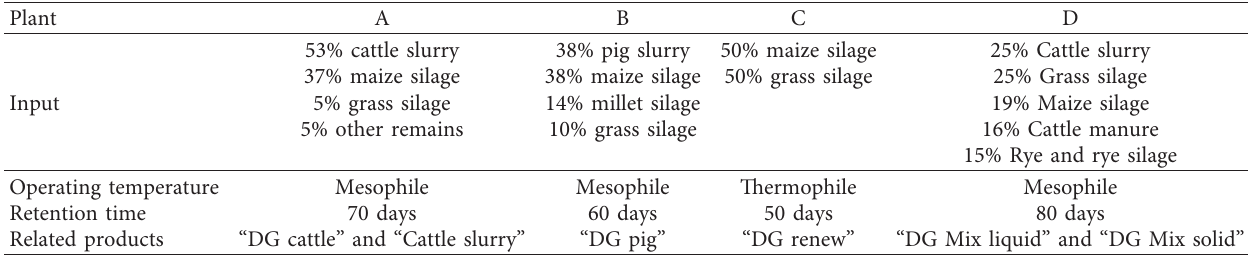
Table 1: Input material and operating parameters of the four biogas plants included in the study and given designations of the resulting digestates (“DG”).